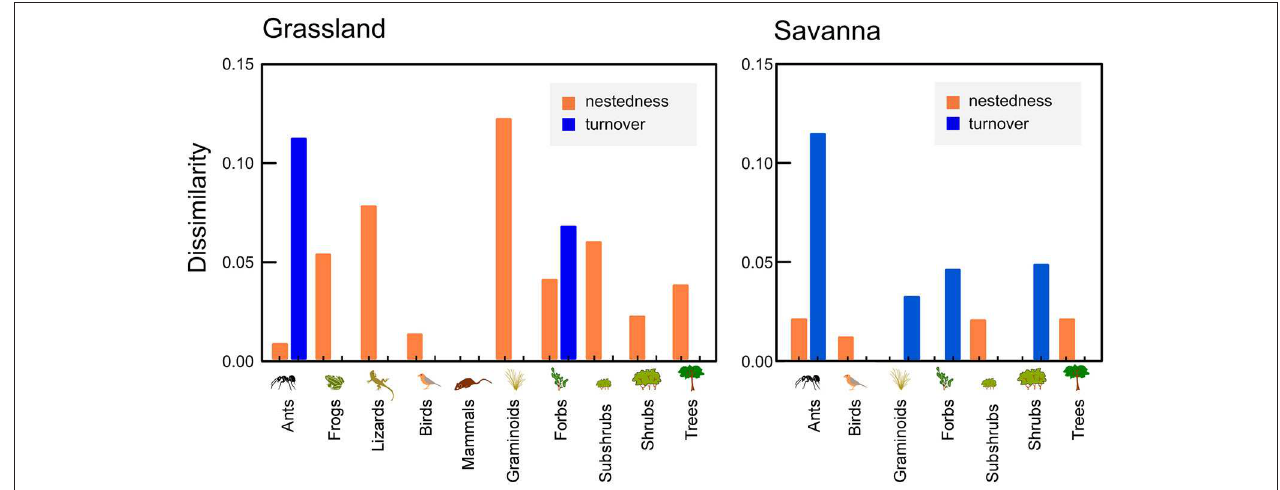
FIGURE 6 | Degree of dissimilarity in species composition (due to turnover or nestedness) between burned and unburned areas for different plant and animal groups in grasslands and savannas, at Santa Bárbara Ecological Station, state of São Paulo, Brazil.